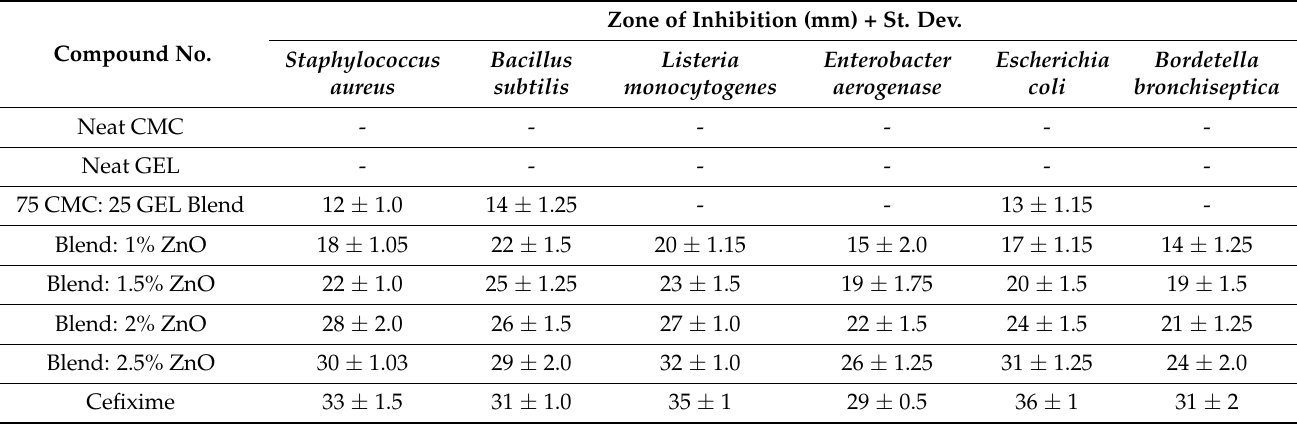
Table 4. Antibacterial activity of CMC/GEL/ZnO-Nps hydrogel films. Zone of Inhibition (mm) + St. Compound No.